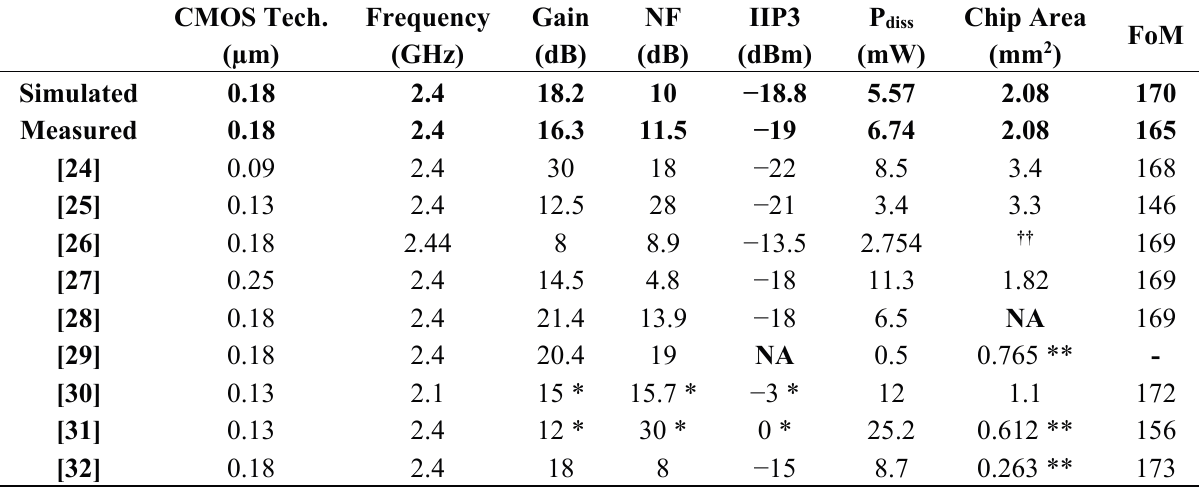
Table 2. Performance comparison with related